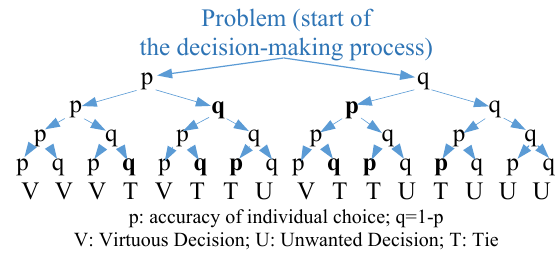
Figure 4: Efficiency of a group of 4 decision-making elements. Events marked with a bold letter represent the tie situations.